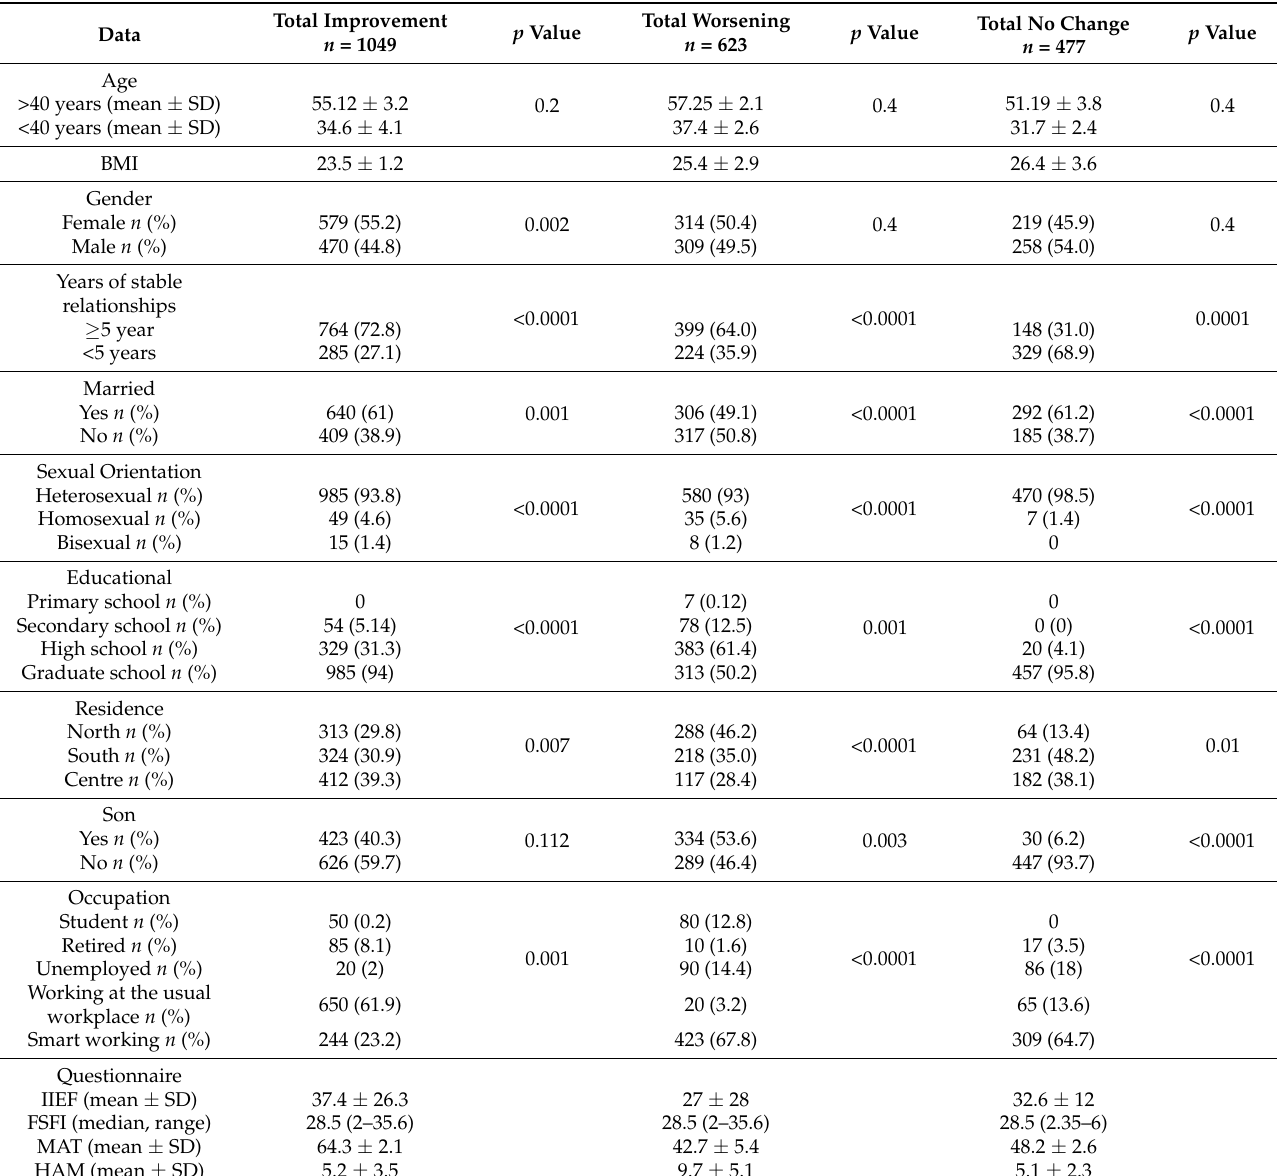
Table 3. Demographic data on subjects who reported an improvement, worsening, or no changes in the couple’s sex